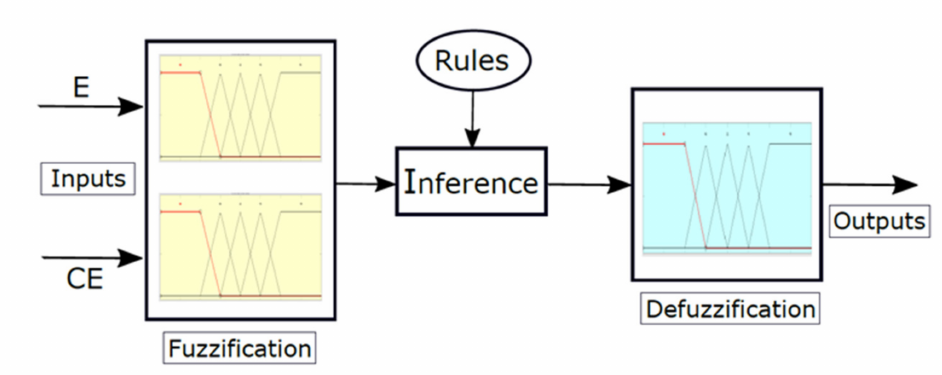
Figure 6. Structure of fuzzy controller.